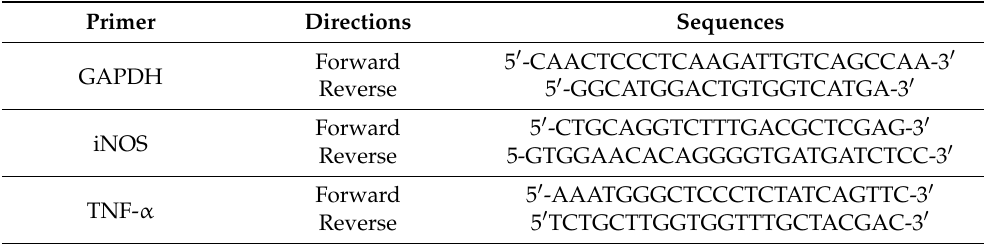
Table 1. Sequences of primers for real-time RT-PCR